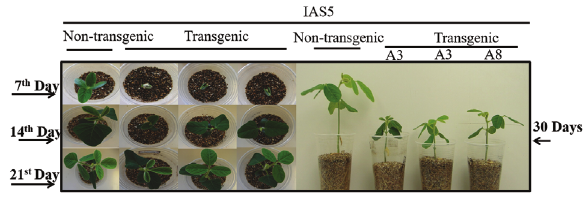
Figure 3 - Transgenic and non-transgenic plants seven, 14, 21 and 30 days after germination. Transgenic plants and non-transgenic plants are from cv.